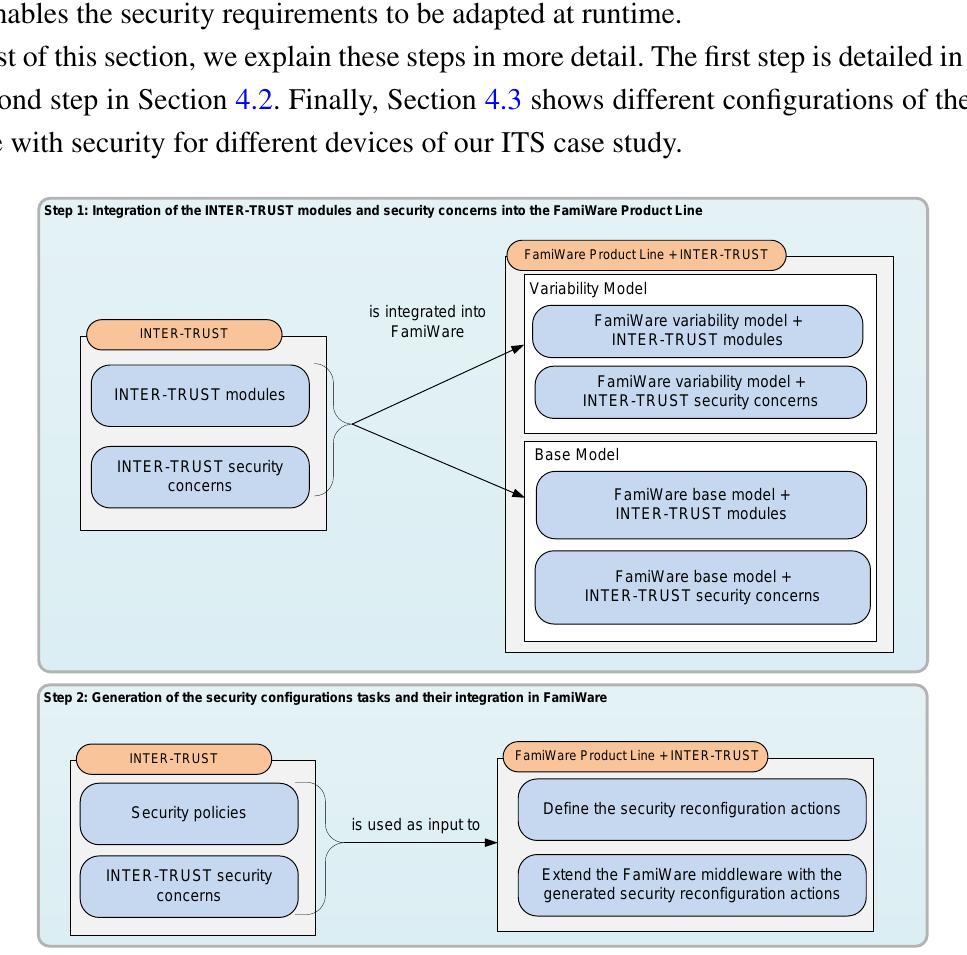
Figure 4. Steps for the integration of INTER-TRUST into the FamiWare family of